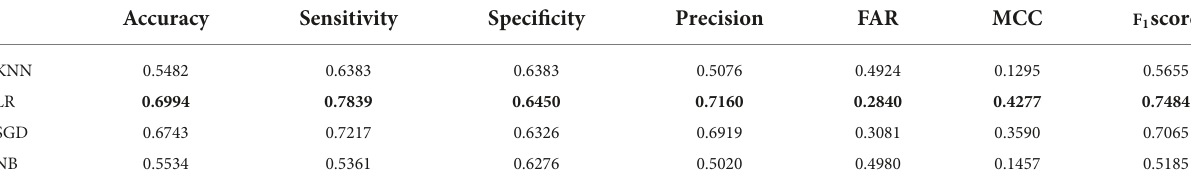
TABLE 8 PD-detection performance metrics for four different classifiers by using articulation features selected by Relief-F selection algorithm.